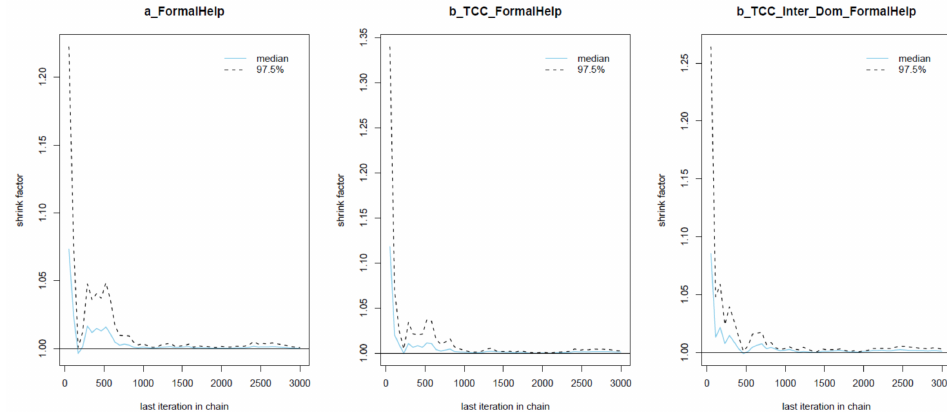
Figure A5. Gelman plots for Model 3 (cid:48) s posterior